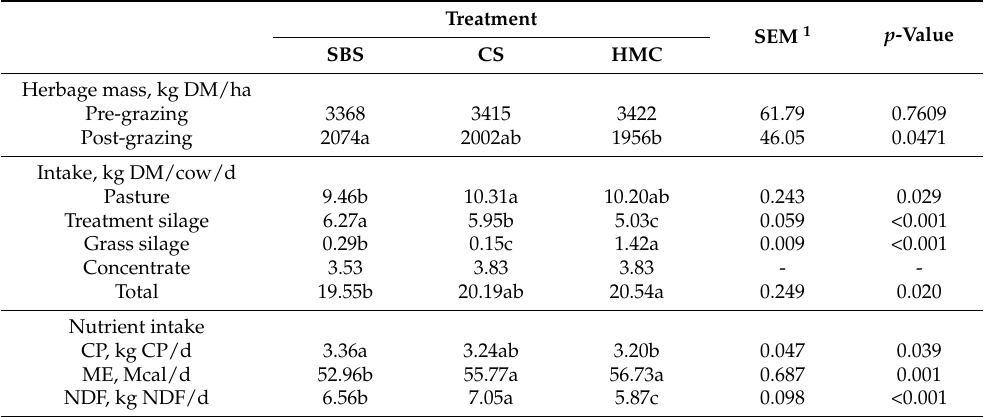
Table 3. Grazing management and dry mater intake (DMI) of grazing dairy cows supplemented with PMR composited by sugar beet silage, corn silage, or HMC. Treatment SEM 1 p -Value SBS CS